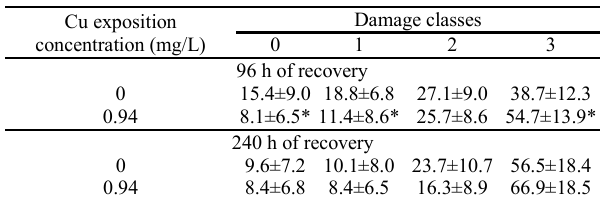
Table 2. Frequency (%) of classes of DNA damage in erythrocytes of the Centropomus paralellus maintained under control condition (no Cu addition into the sea water) for the whole experimental period or pre-exposed (96 h) to Cu (0.94 mg/L), transferred to control sea water and maintained under this condition for recovery during 96 and 240 h. Data are expressed as mean ± standard deviation. *Denotes significant different mean values between control and fish pre-exposed to Cu (p<0.05).